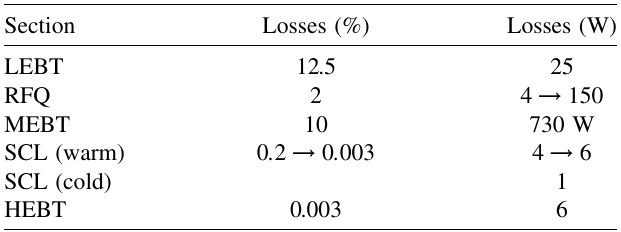
TABLE I. Loss tolerances. For the accelerating structures, the first value corresponds to the tolerance at the beginning of the structure and the last one to the